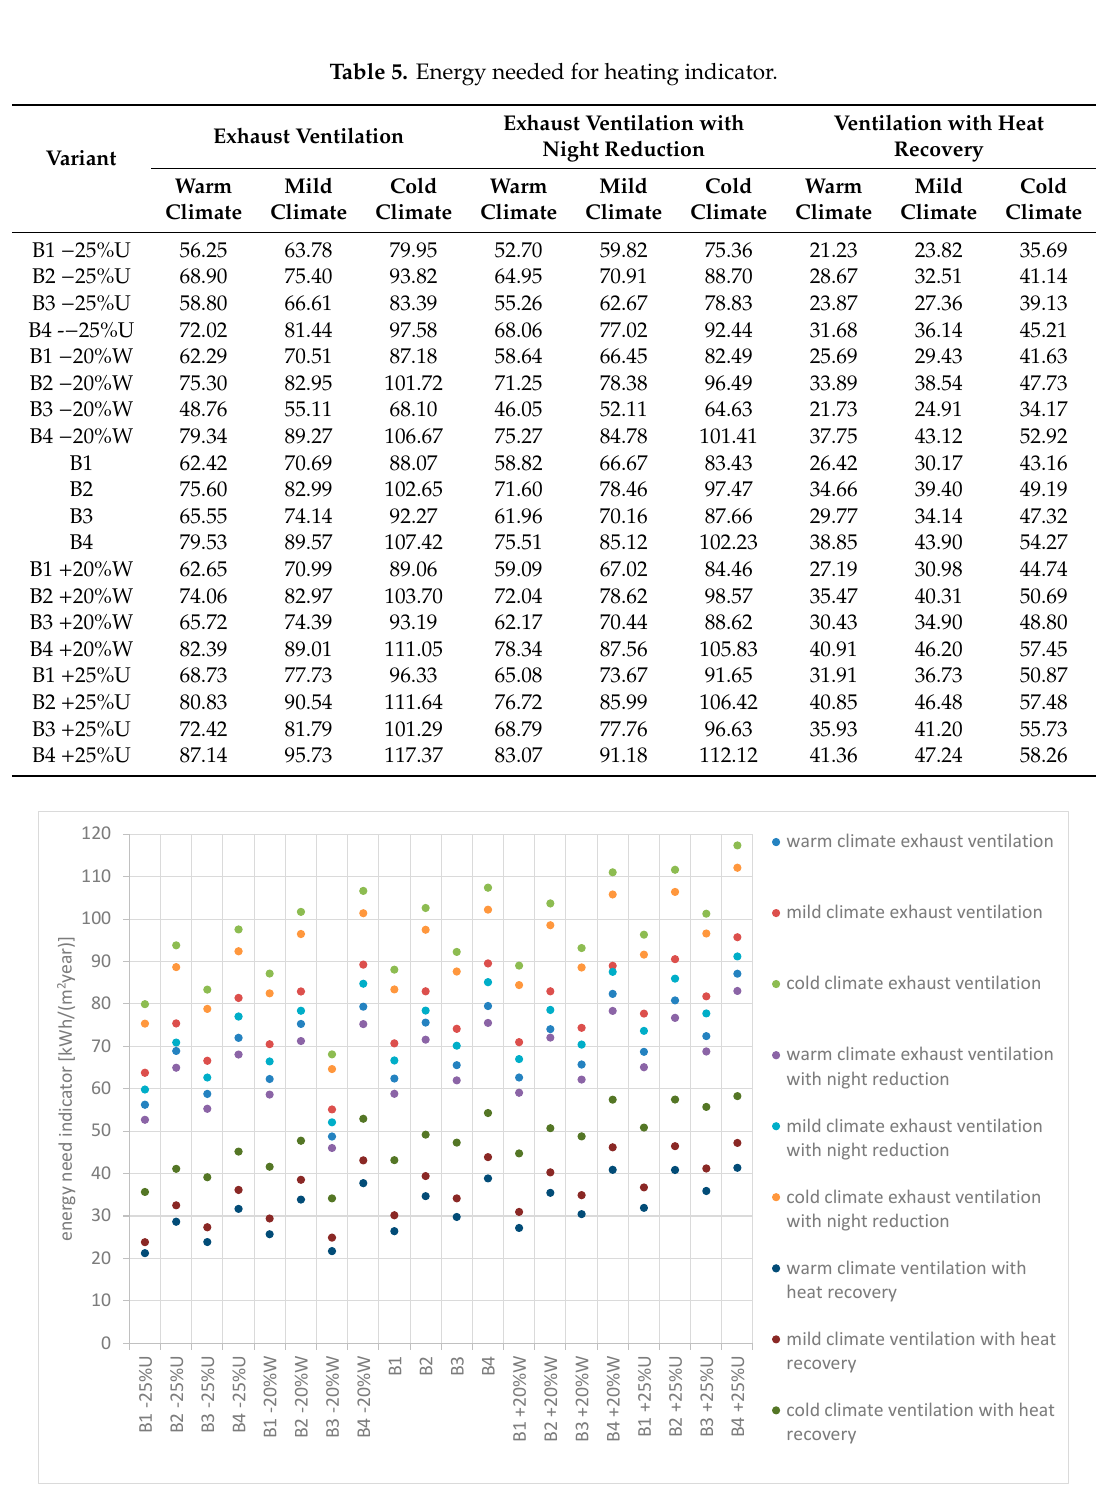
Figure 3. Energy needed for heating indicator for all analyzed variants.